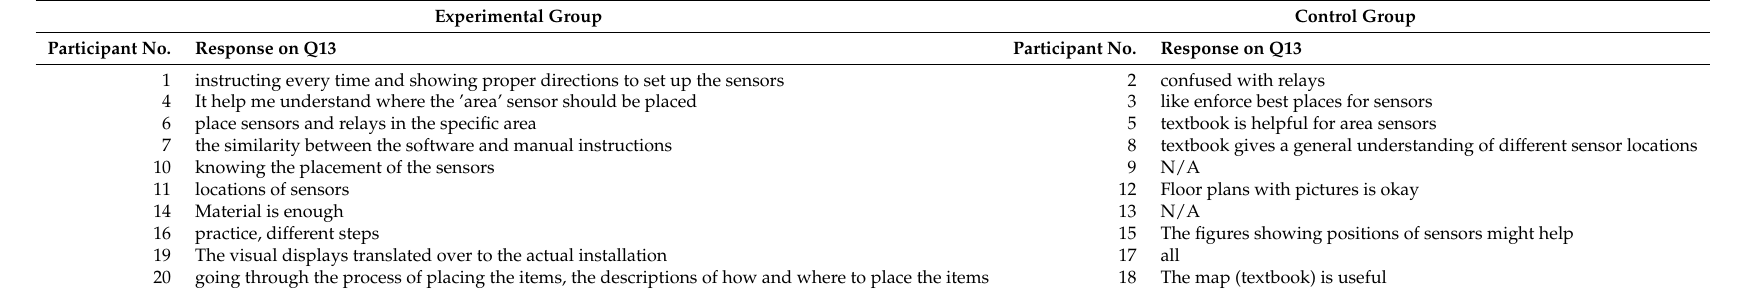
Table 6. Responses to Q13 of the experimental group and the control